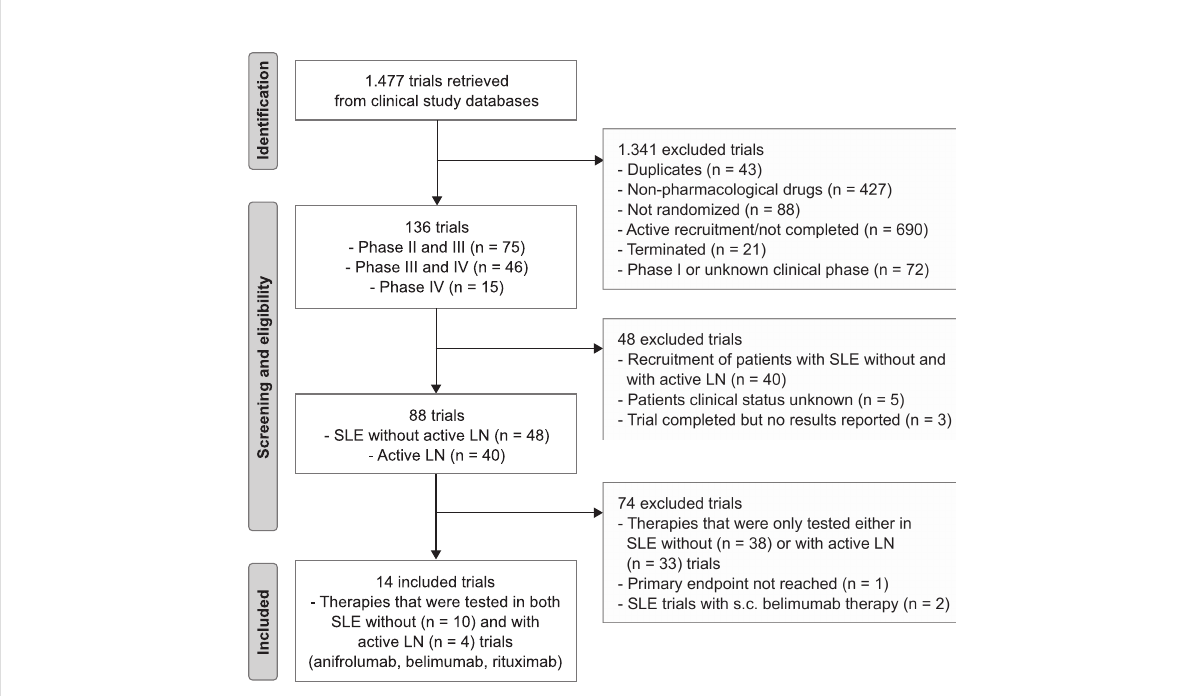
FIGURE 1 Trial fl ow chart. The search identi fi ed 1.477 trials for lupus from clinical study databases. After excluding 1.463, 14 randomized control trials (RCTs) were used for this systemic review and meta-analysis in which therapies (anifrolumab, belimumab and rituximab) were tested in both patients with systemic lupus erythematosus (SLE, n = 10) without active lupus nephritis (LN) and with active LN (LN, n = 4) patients. S.c.,